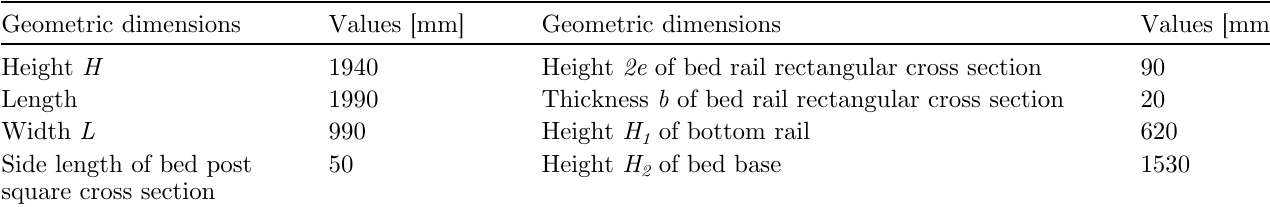
Table 6. Geometric dimensions of the high loft